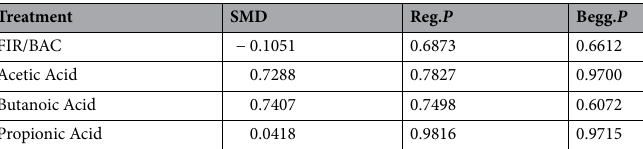
Table 8. Data stability analysis of the studies using Egger’s regression and Beggs test. *The test is not significant [Reg. P < 0.001], indicating funnel plot asymmetry.